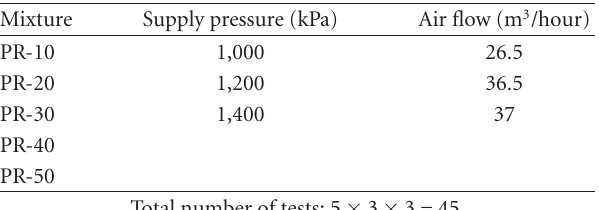
Table 8: Tests to be carried out with regard to control parameters.